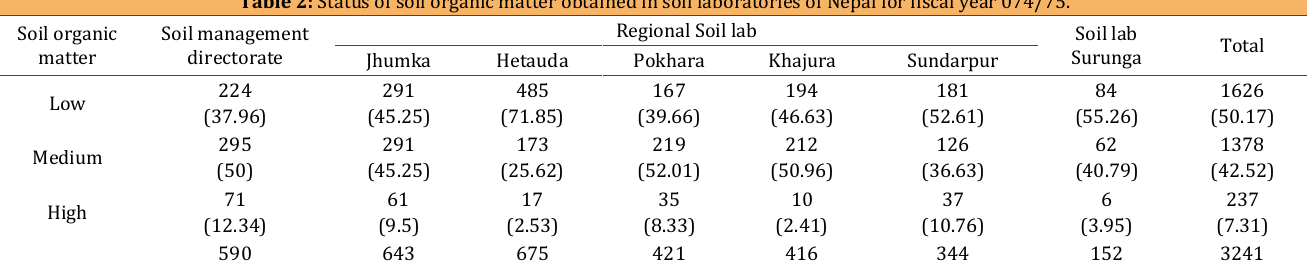
Status of soil organic matter obtained in soil laboratories of Nepal for fiscal year